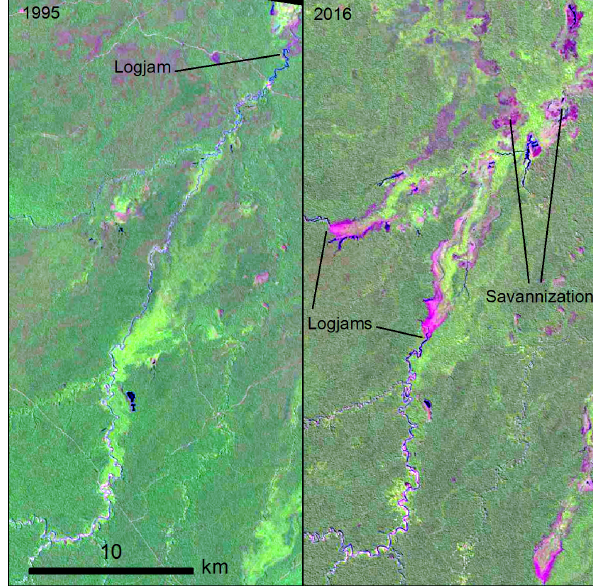
Figure 7. Landsat image of the Tequeje River in 2016. The river flows from west to east. The green dots with the red labels indicate the location and year of past logjams. The inset shows the evolution of the river channel from 1987 to 2015 at 4-year intervals.